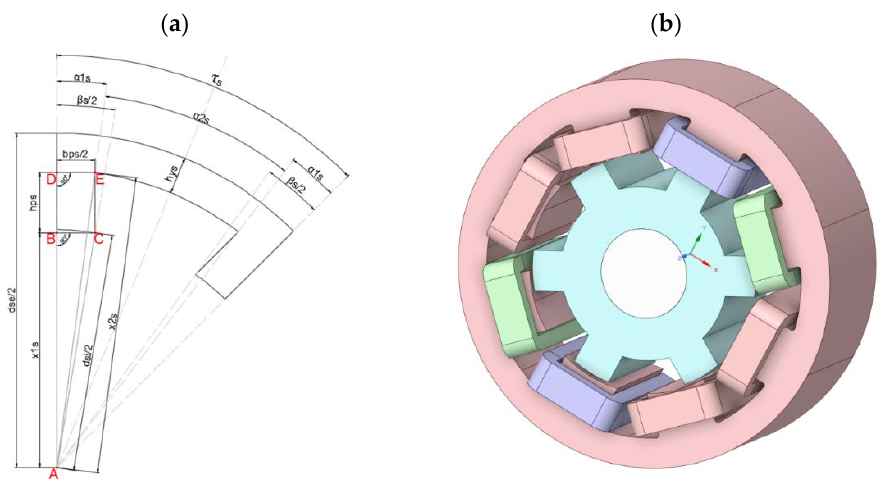
Figure 13. Exemplary construction geometry determination process for 8/6 SRM motor: ( a ) stator fragment with marked design parameters, ( b ) 3D ANSYS representation of modeled 8/6 SRM motor.